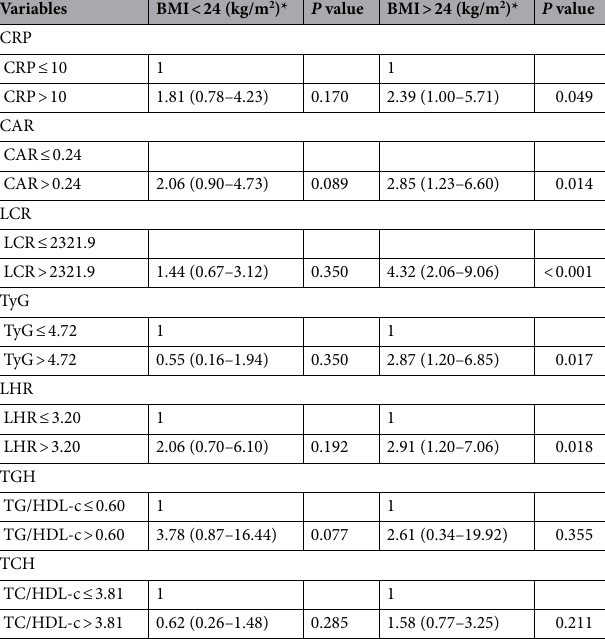
Table 3. Survival analysis stratified by different BMI groups. CRP C-reactive protein, LHR LDL-c/HDL-c ratio, HDL-c high-density lipoprotein cholesterol, LDL-c low-density lipoprotein cholesterol, HR hazards ratio, CI confidence interval, BMI body mass index, KPS karnofsky performance status, TSF triceps skinfold thickness. *Adjusted for age, tumor stage, KPS, surgery, chemotherapy, radiotherapy, immunotherapy, family history of cancer, tumor metastasis, diabetes, hypertension, coronary heart disease, and